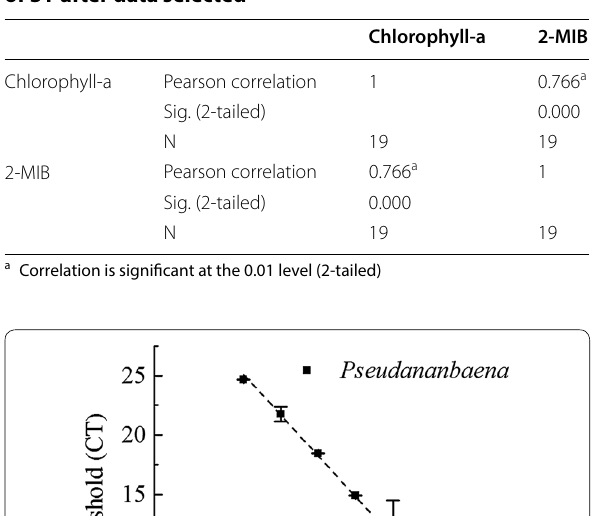
(Table 6). This also indicates that Pseudanabaena sp. is probably the source of 2-MIB.